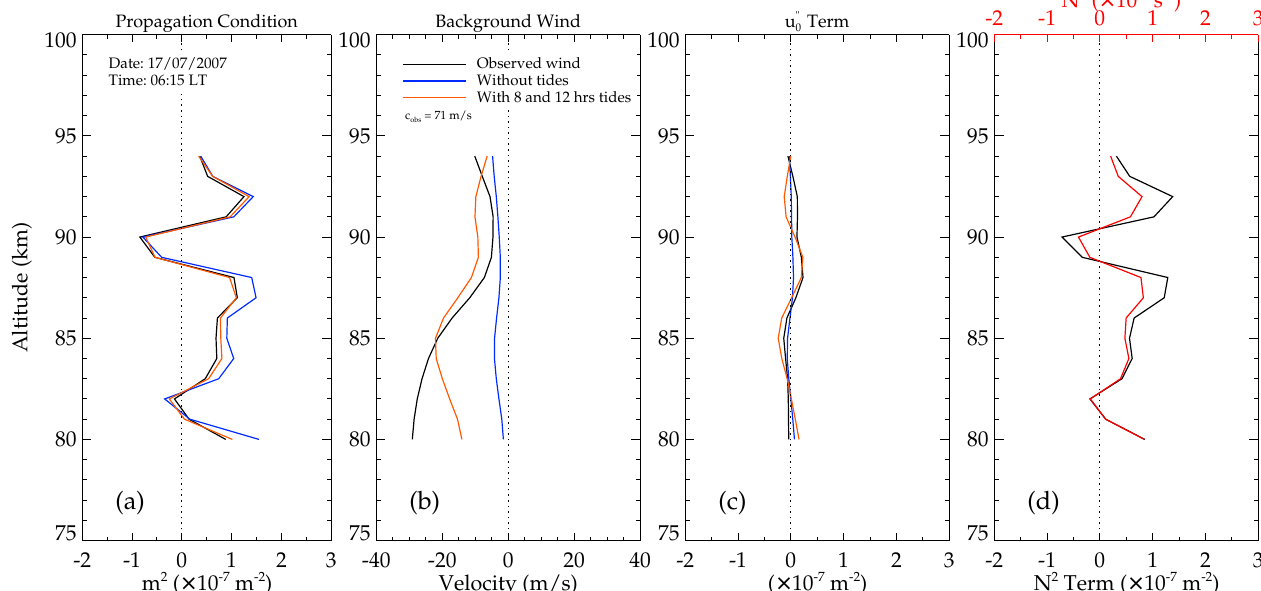
Fig. 7. (a) Vertical propagation condition for the different wind profiles, according with different wind conditions. (b) Observed wind, mean wind (without tidal components) and tidal winds (mean wind plus the components of 8 and 12h). (c) Terms of the second derivative winds, i.e., the second term in Eq. (1). (d) Squared Brunt-V¨ais¨al¨a frequency, N 2 , and its associated term in Eq. (1).